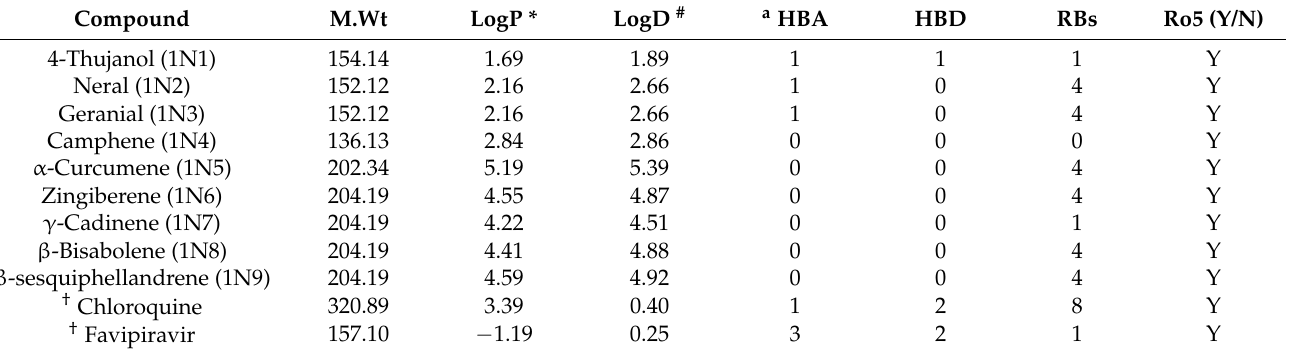
Table 3. Lipinski’s filters for